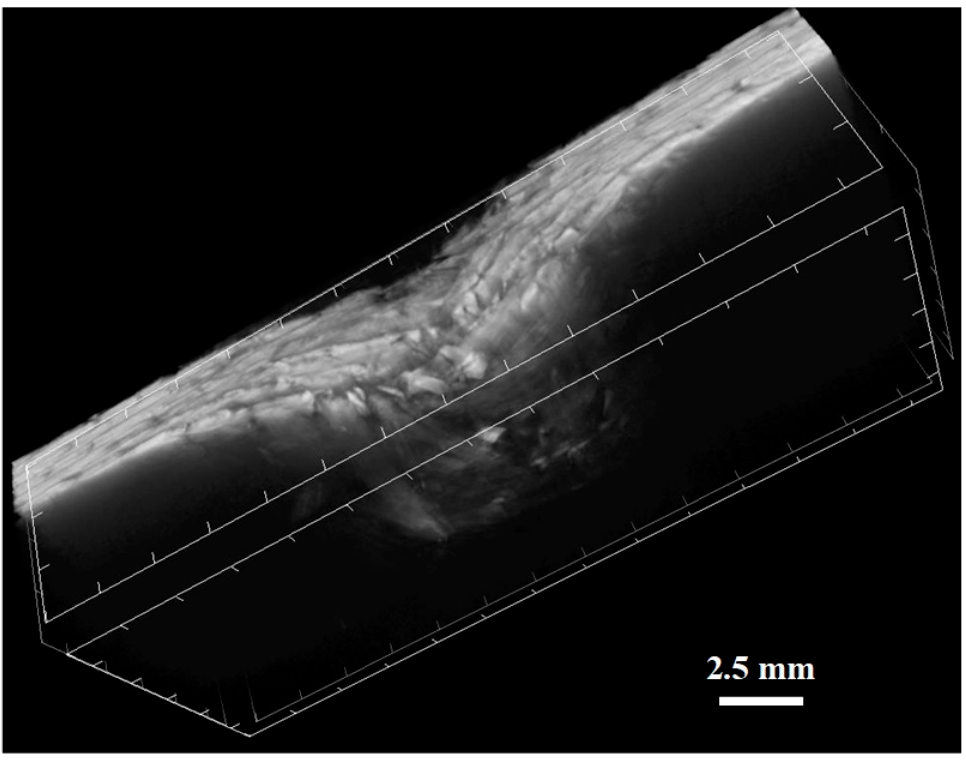
Figure 8. 3D image after impact test of E-glass fiber reinforced geopolymer composite. The part shows the area of impact.